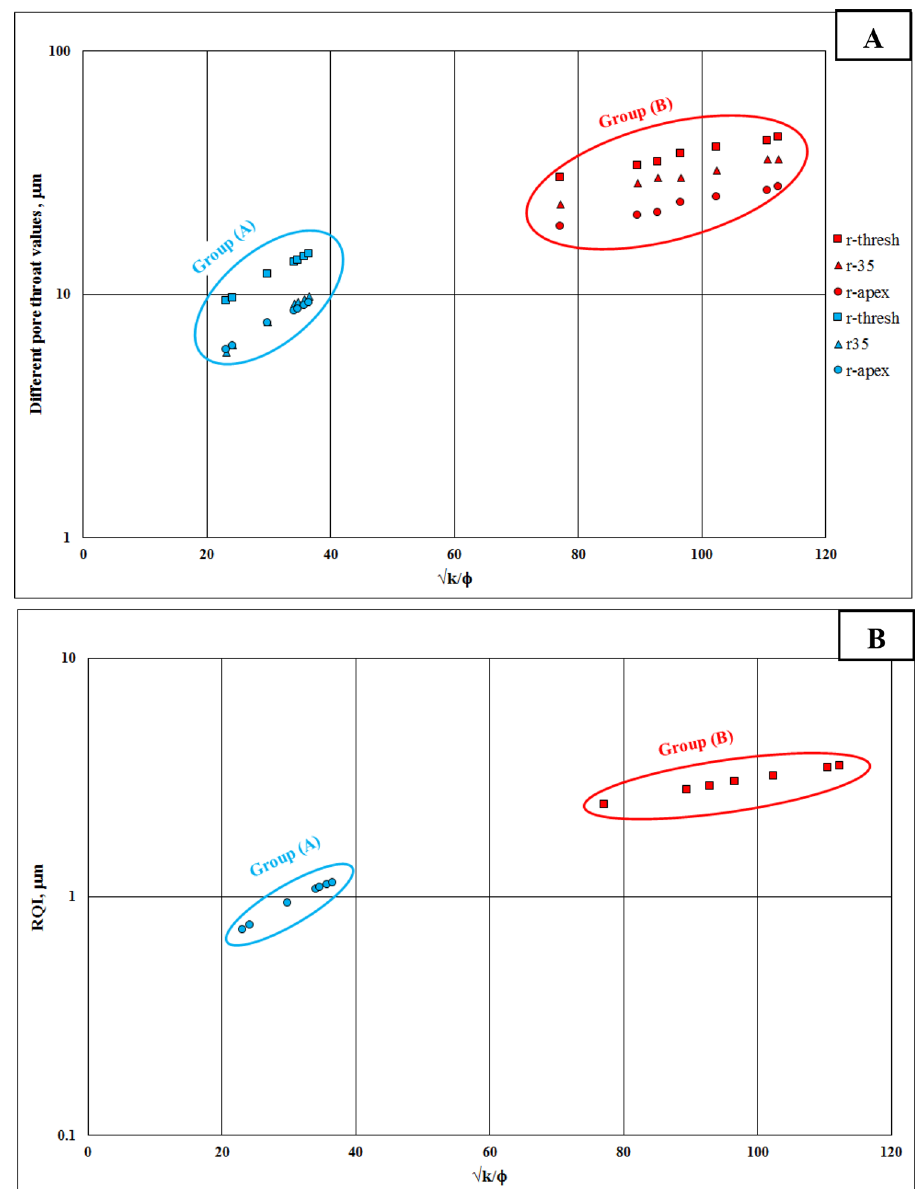
Fig. 6 a Different pore throat values (μm) versus √ k / ϕ b RQI versus √ k /